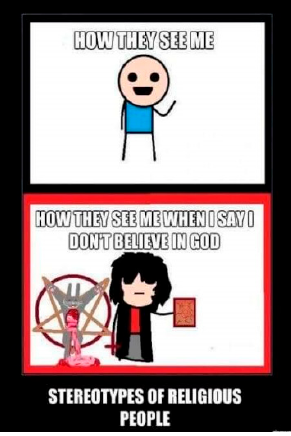
Figure 6. © unknown.